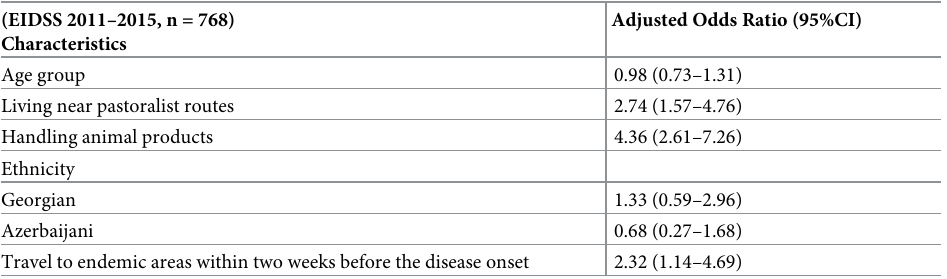
Table 3. Binary multiple logistic regression analysis of risk factors for a confirmed/probable cutaneous